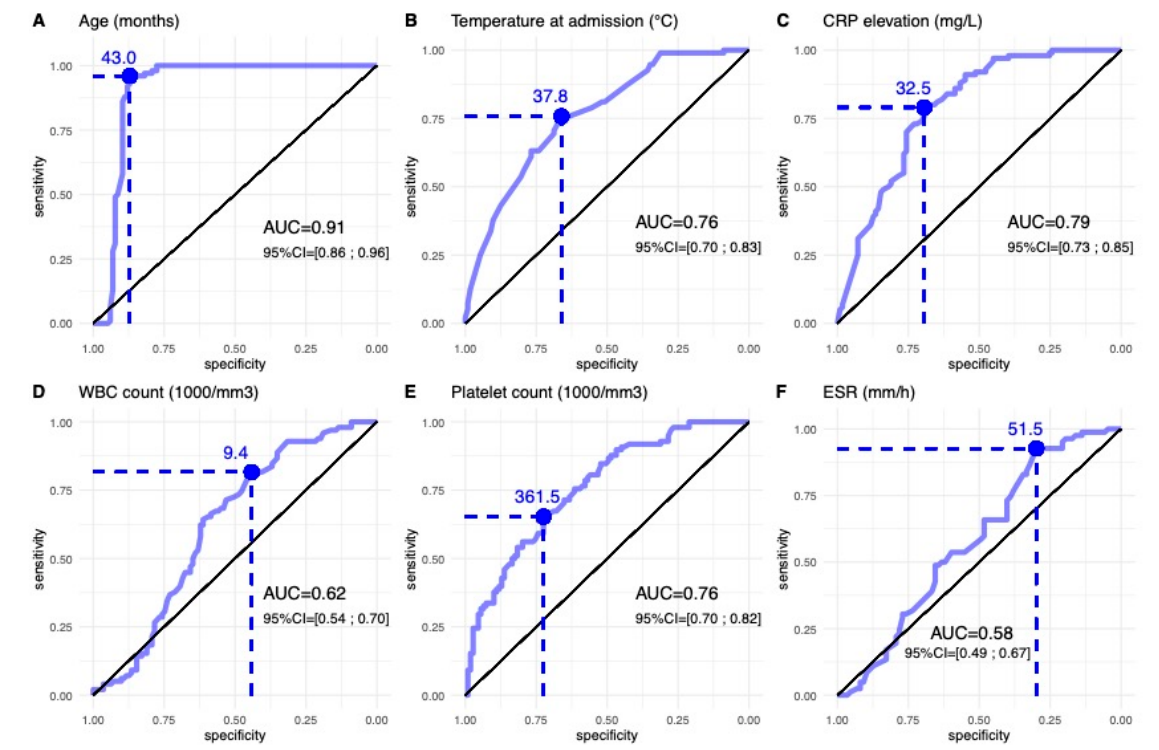
Figure 3. ROC curves for age, temperature at admission, CRP elevation, WBC count, platelet count and ESR to discriminate K. kingae OAIs (n = 100) from S. aureus OAIs (n = 116). AUC is area under curve, with associated 95% confidence interval (CI).